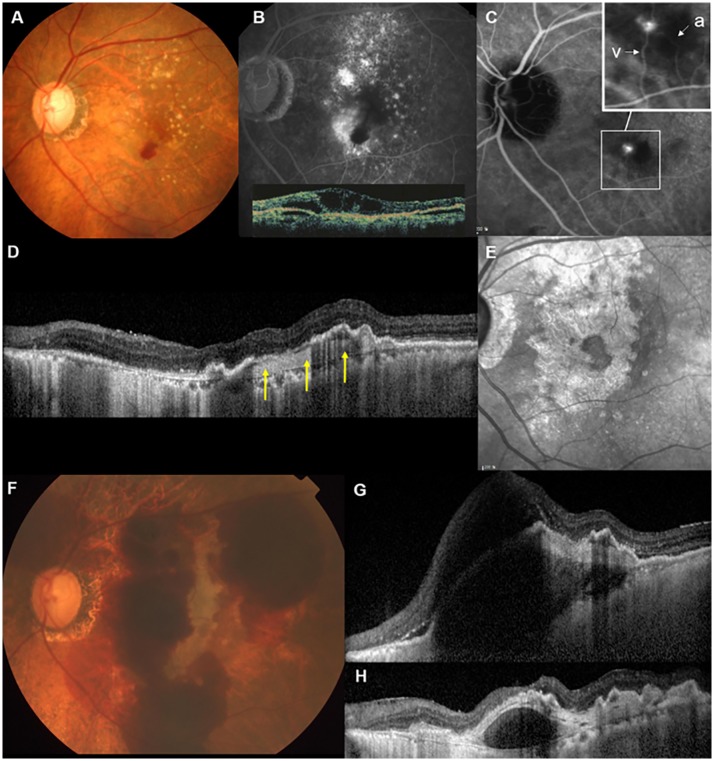
Massive subretinal hemorrhage (SRH) in patient 14, a 69-year-old female with retinal angiomatous proliferation (RAP).(A) At baseline (July 2007), the color fundus photograph showed multiple drusen and retinal hemorrhages inferior to the fovea. (B) Fluorescein angiography (FA) showed intraretinal leakage and blocked fluorescence due to retinal hemorrhage. Inset: Vertical scan through the fovea on Stratus optical coherence tomography (OCT) demonstrated cystic space in the neurosensory retina and pigment epithelium detachment (PED). (C) Mid-to-late phase indocyanine green angiography (ICGA) revealed a small hot-spot lesion, in which an anastomosis between the retinal arteriole (a) and venule (v) was detected on mid-phase ICGA (inset). Best-corrected visual acuity (BCVA) of the left eye was 20/40, and the patient received a combination treatment of photodynamic therapy and bevacizumab injection. After the initial treatment, six ranibizumab and eight bevacizumab injections were performed during the follow-up period; however, the BCVA decreased to 20/200 at 97 months after the initial treatment. (D) Sectional spectral domain (SD)-OCT of the fovea taken at that visit showed well-organized layered lamellar tissue within fibrovascular PED (arrows) as well as atrophic retinal pigment epithelium (RPE) and increased signal transmission in the choroid. (E) Near-infrared images confirmed the development of geographic atrophy during the follow-up period. (F) One month later, massive SRH extending to the major vascular arcade developed. (G) SD-OCT showed subretinal and sub-RPE hemorrhage involving the fovea. The patient received a single bevacizumab injection with gas/rt-PA injection, and 6 months later, BCVA decreased to hand motion. (H) SD-OCT showed the contraction of layered lamellar tissue, and as a result, hyporeflective space was noted, separating the neovascular tissue from the underlying choroid and Bruch’s membrane.